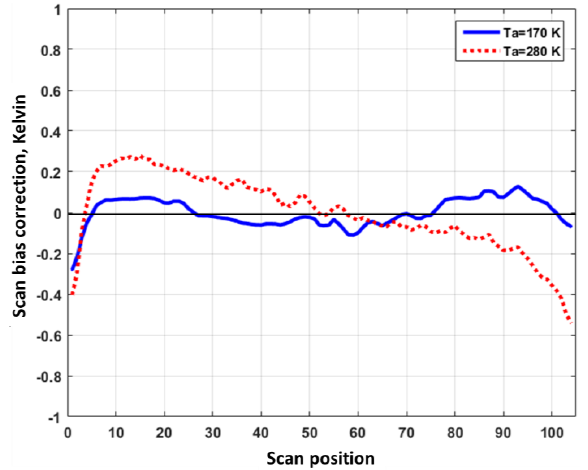
Figure 1. Scan bias correction for channel 10.65 V for Ta = 170 K ( blue solid line ) and Ta = 280 K ( red dashed line ).